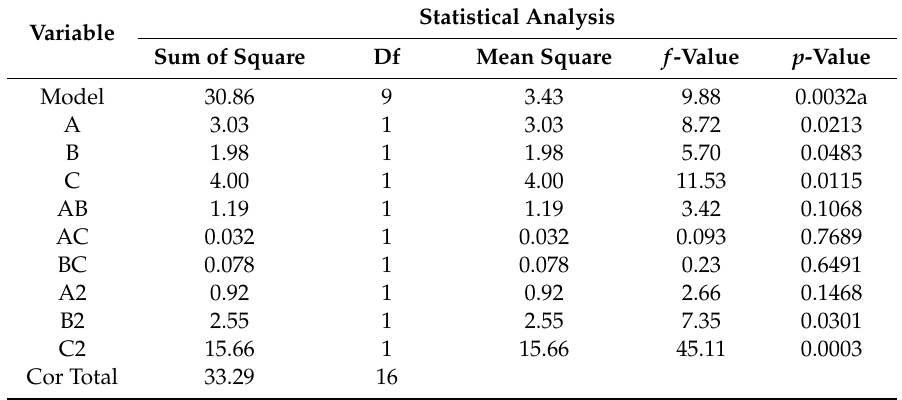
Table 5. ANOVA for the brightness of fly ash according to the response surface quadratic model. Variable